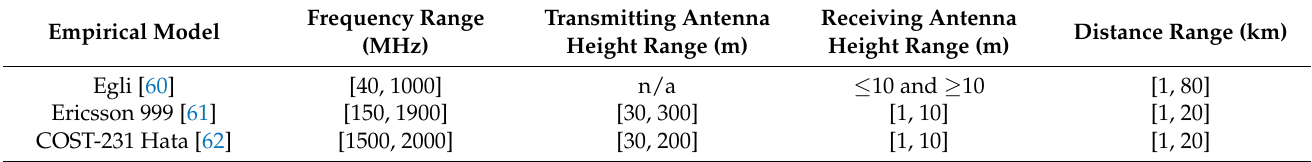
Table 6. Empirical models and their input parameter